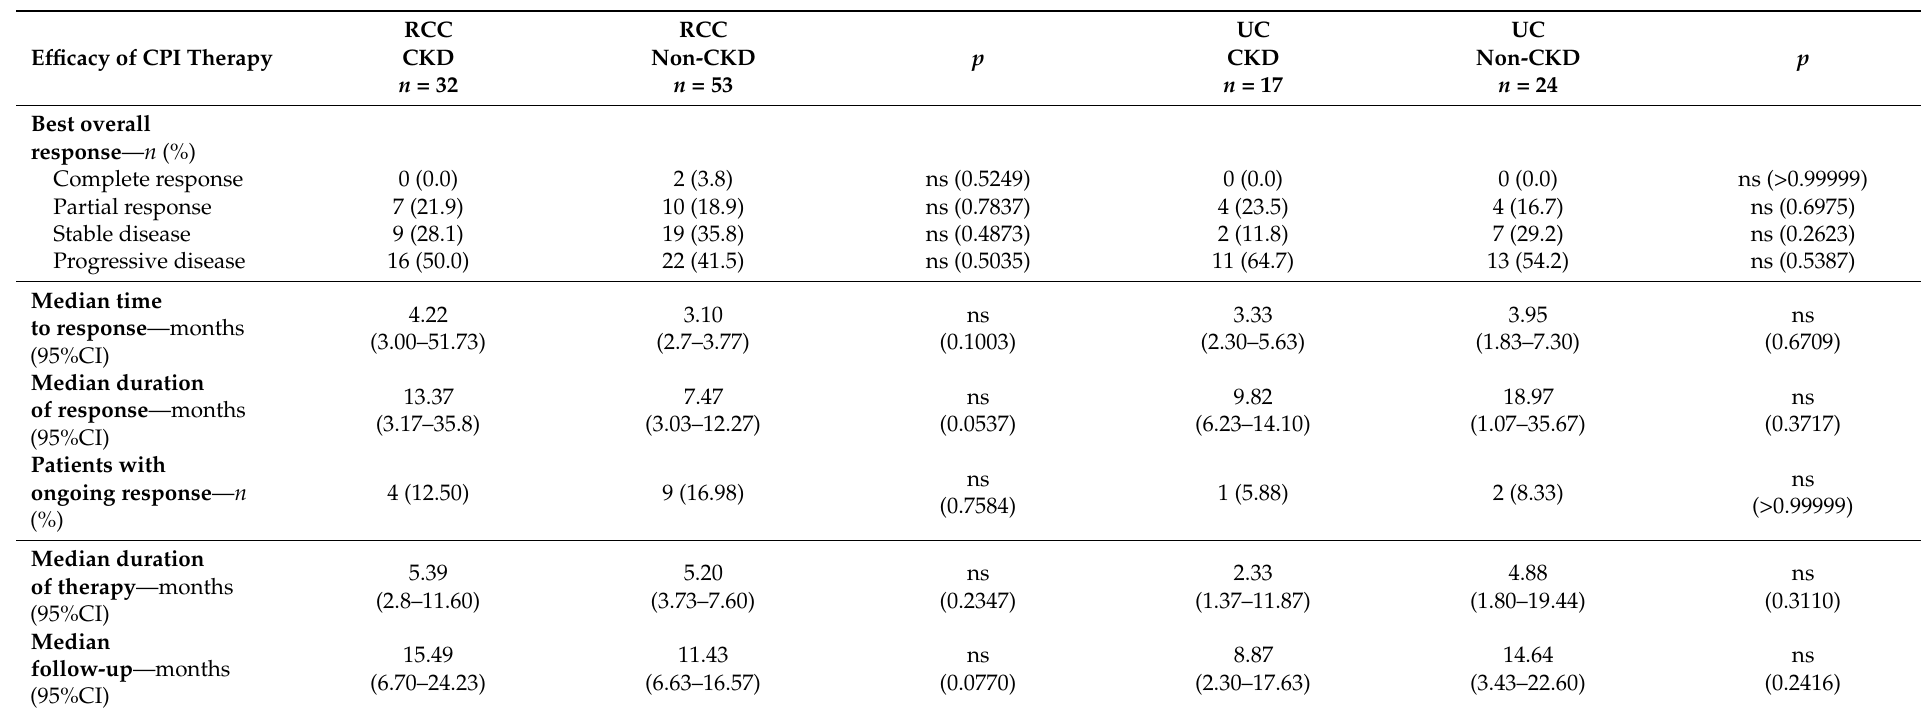
Table 6. Efficacy of checkpoint inhibitor therapy. CKD = chronic kidney disease; RCC = renal cell carcinoma; UC = urothelial carcinoma; ns = not